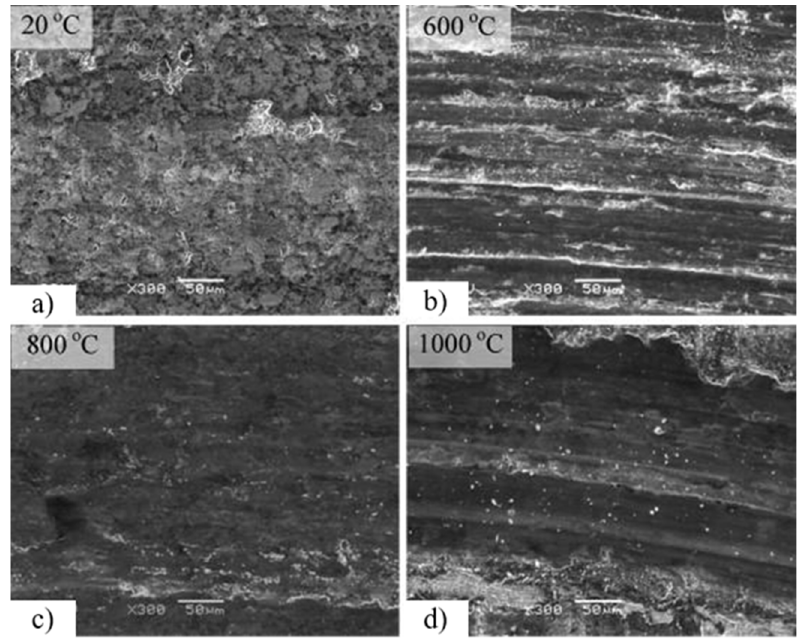
Figure 10. Worn surface of the composite at different temperatures ( a ) RT, ( b ) 600 °C, ( c ) 800 °C, ( d ) 1000 °C for CuO-based composite. Reproduced with permission from [29]. Copyright Elsevier, 2012.